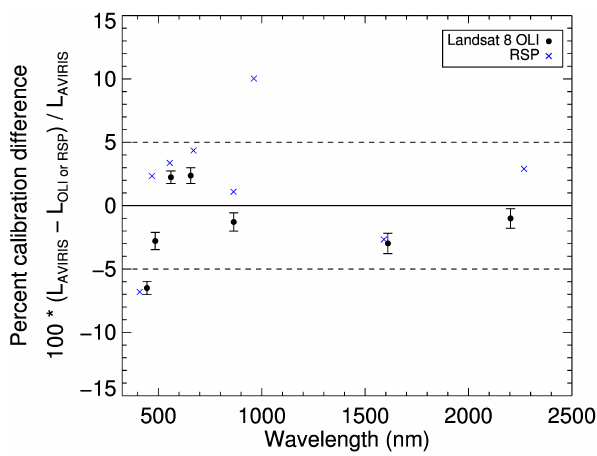
Figure 8. The percent difference in radiance between band- averaged AVIRIS and the multispectral sensors, RSP and OLI.